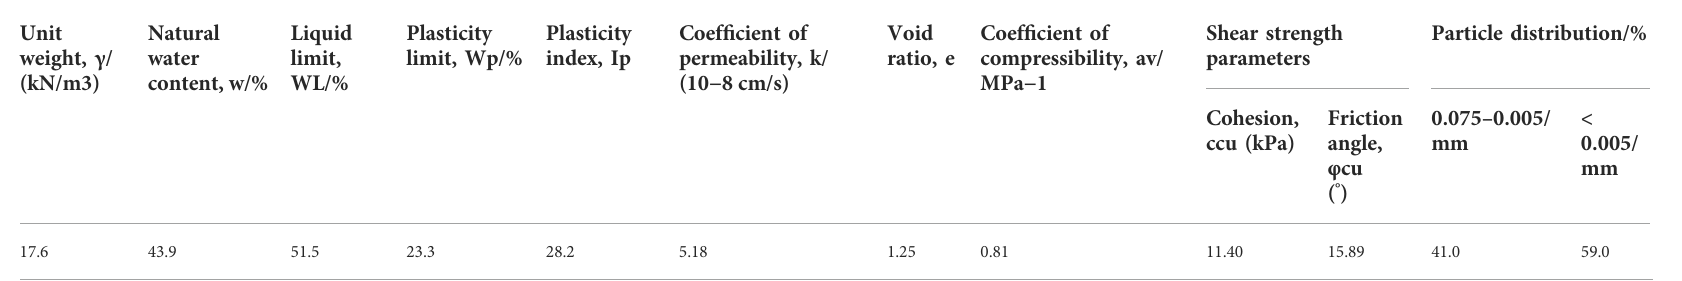
TABLE 1 Physico-mechanical indices of the remolded Ningbo clay. Unit weight, γ